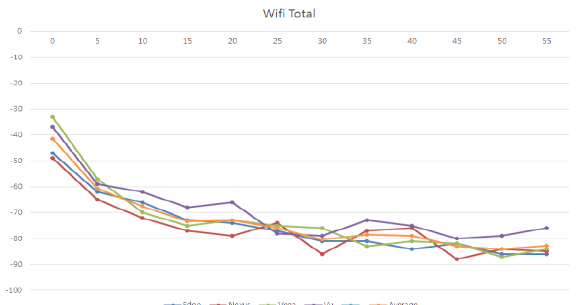
Figure 1. Wi-Fi signal curve by each smart phone